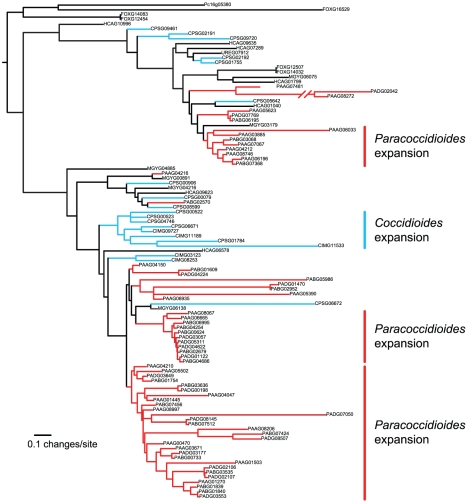
Phylogenetic relationships of FunK1 kinases estimated by maximum likelihood with RAxML [103].Lineage-specific expansions can be seen in Paracoccidioides (red) and Coccidioides (blue).